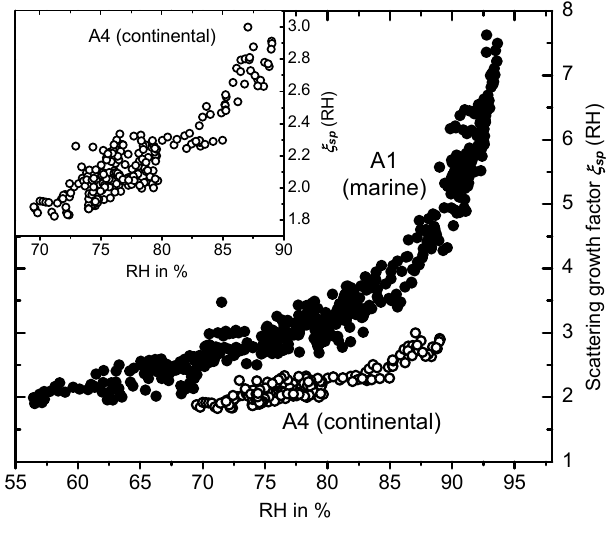
Fig. 12. Growth factors of particle scattering ( ξ sp (RH)= σ sp , amb /σ sp , dry ) as a function of relative humidity (RH). The data sets were classified into two cases, marine (23–25 September 2005) and continentally polluted (6–9 October 2005), with a subset containing the zoom-in pattern of the continentally polluted